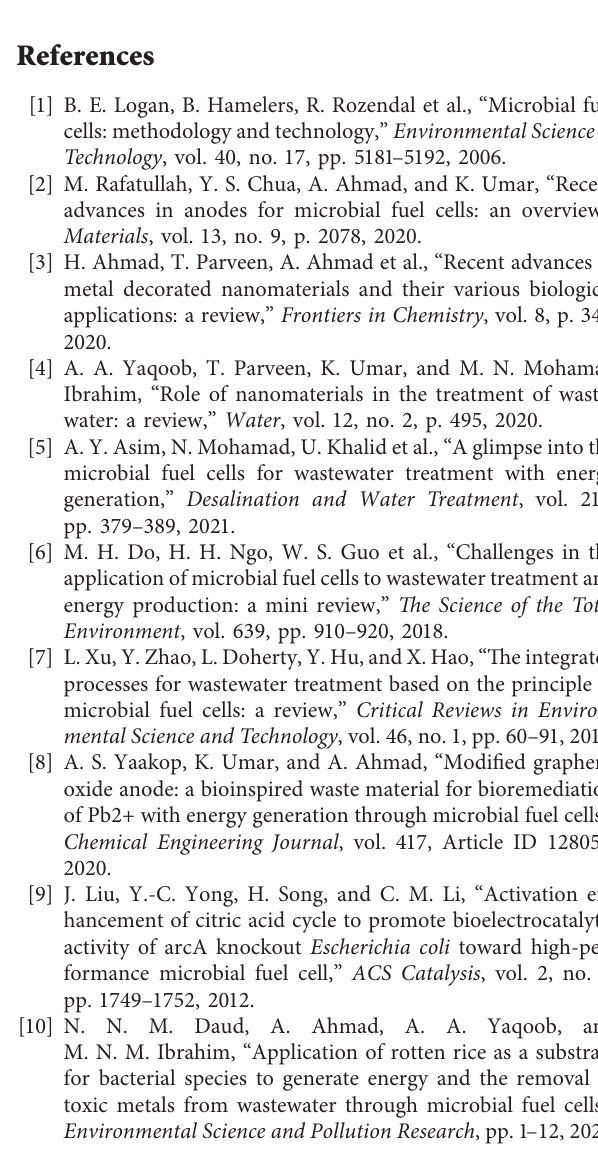
Figure 5: Electron transfer mechanism from a bacterial cell to the anode’s surface (adapted from reference [20] with Elsevier’s